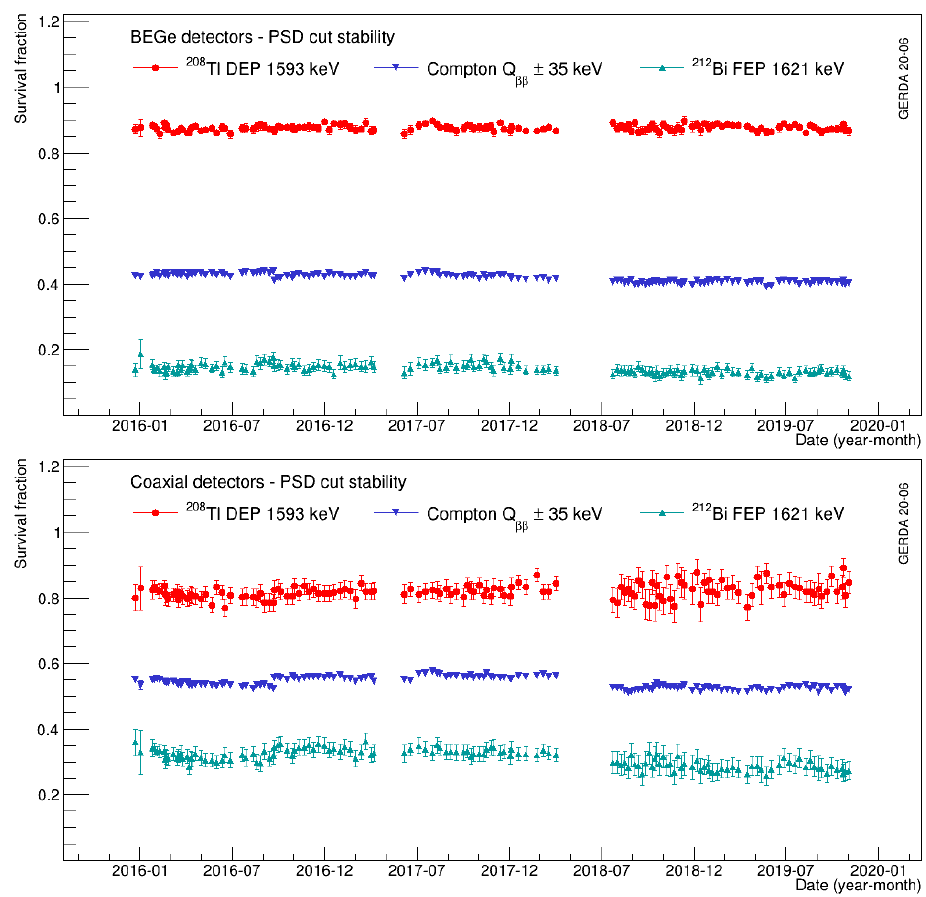
Figure 24. Survival fractions, based on 228 Th calibration data, as a function of time relative to the DEP, Compton and FEP peaks for both BEGe ( upper panel) and semi-coaxial ( lower panel)